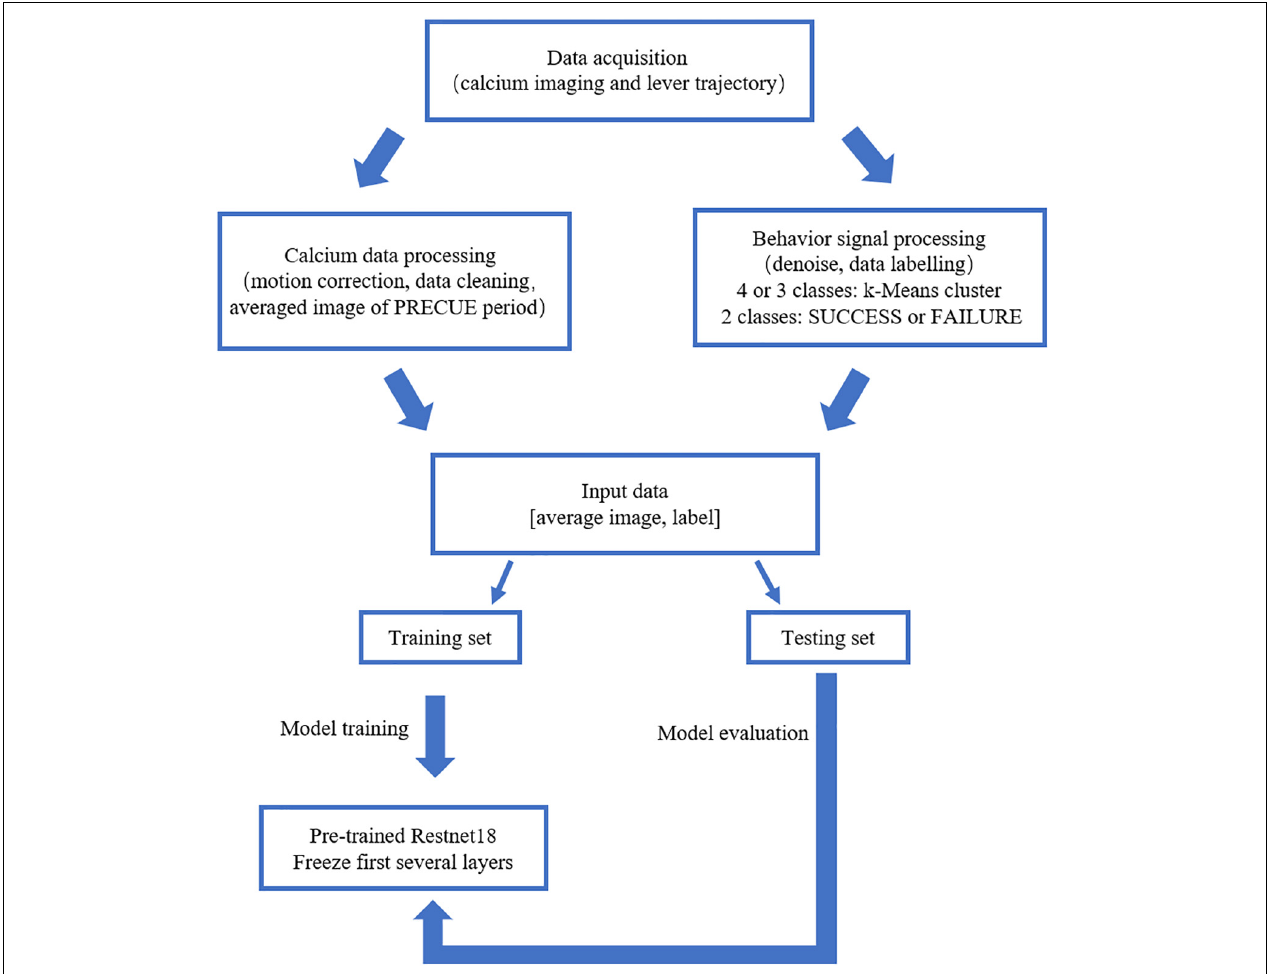
FIGURE 2 | Outline of the data analysis procedure. Calcium imaging data recorded in PRECUE period were collected in synchrony with forelimb movement parameters. TurboReg was used to remove motion artifacts of the imaging data within each trial. Behavioral data were denoised, labeled and k-Means algorithm was used to cluster maximum lever reaching position of all trials. The averaged calcium image were used to predict the result of each trial (SUCCESS or FAILURE) and the maximum lever reaching position. The prediction model was a pre-trained Resnet18. Transfer learning scheme was adopted due to the small sample size. The proportion of the training set and testing was set at a ratio of